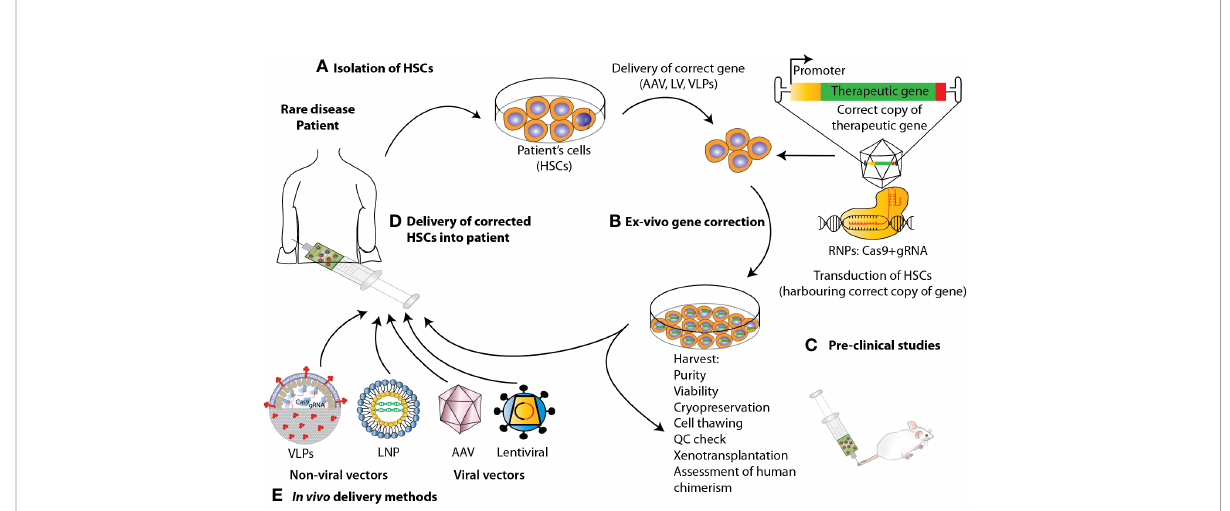
FIGURE 2 State-of-the-art ex vivo and in vivo gene therapy and gene editing strategies applied to HSPCs to correct blood genetic disorders via delivery of a corrective gene. Schematic representation of the various steps involved in the development of a therapeutic product for the treatment of blood diseases via gene therapy. For the ex-vivo approach, (A) HSPCs are isolated from mobilized peripheral blood (mPB) apheresis. (B) Using CRISPR/Cas9-based gene editing or LV carrying the gene of interest, these cells are edited/transduced ex vivo and (C) after performing a thorough safety and ef fi cacy quality control (QC) on the product (D) cells are infused back to the patient after pharmacokinetically adjusted myeloablation. (E) When performing gene therapy in vivo , the correct copy of the gene is directly infused into the patient via the use of viral vectors or non-viral methods such as Virus-like Particles (VLPs) and lipid nanoparticles